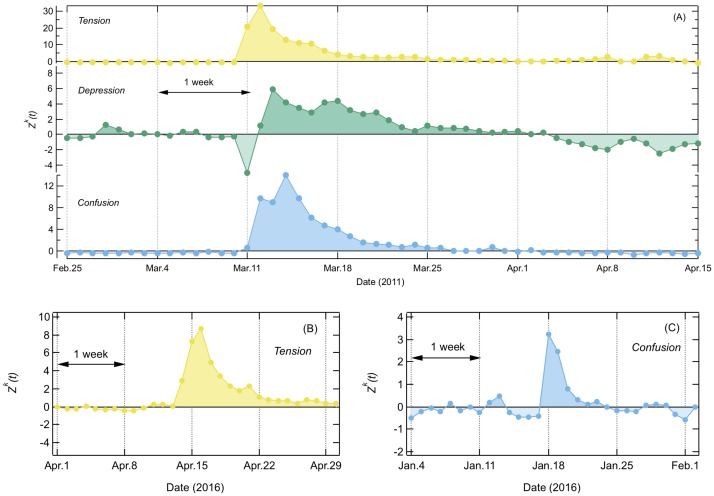
Examples of sharp spikes of collective emotion after removing weekly and yearly periodicities.(A) Tension, Depression, and Confusion continue to increase for more than a week at the 3.11 earthquake period in 2011. (B) Tension at the Kumamoto (the southwest of Japan) earthquake in 2016, and (C) Confusion at the heavy snowfall in the Tokyo metropolitan area in 2016. Except for the 3.11 earthquake, most sharp spikes returned to their original baseline within a week.